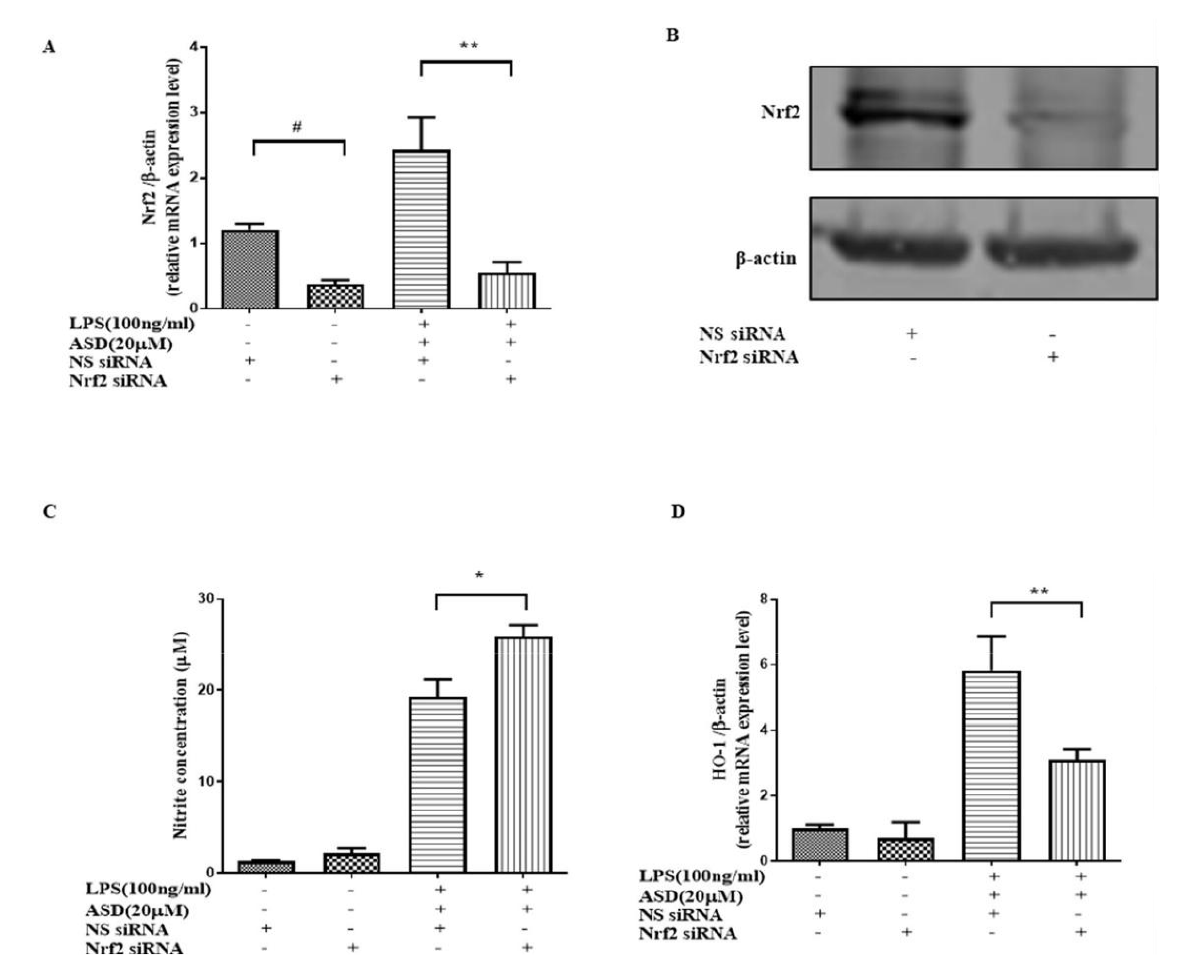
Figure 6. The effect of Nrf2 siRNA on the effect of ASD. The effect of Nrf2 siRNA on the expression levels of Nrf2 ( A , B ), NO ( C ), HO-1 ( D ), and Arg-1 ( E ). The data are shown as the average value ± SD. # p < 0.05 vs. NS siRNA-treated cells ( A ), * p < 0.05, vs. LPS and NS siRNA-induced cells ( A – D ), ** p < 0.01, vs. LPS and NS siRNA-induced cells ( A – D ).